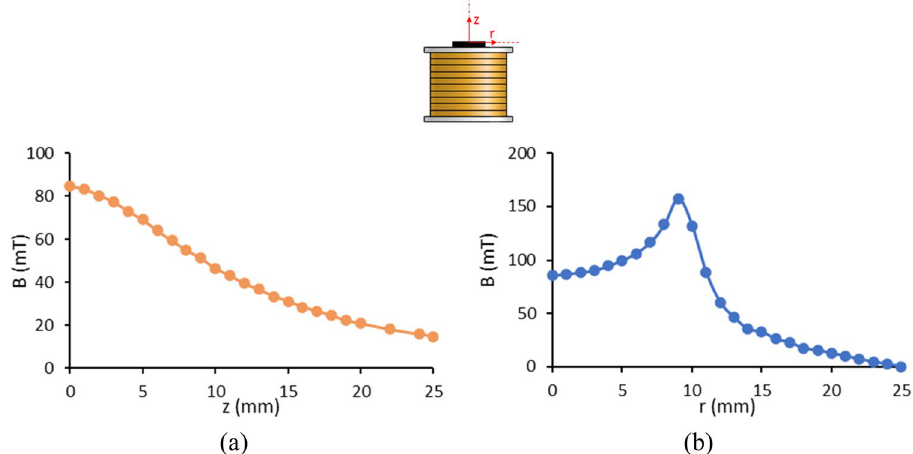
Figure 5. Magnetic flux density in terms of ( a ) the vertical distance on the axis of the magnetic coil and ( b ) the radial distance on the top surface of the magnetic coil.